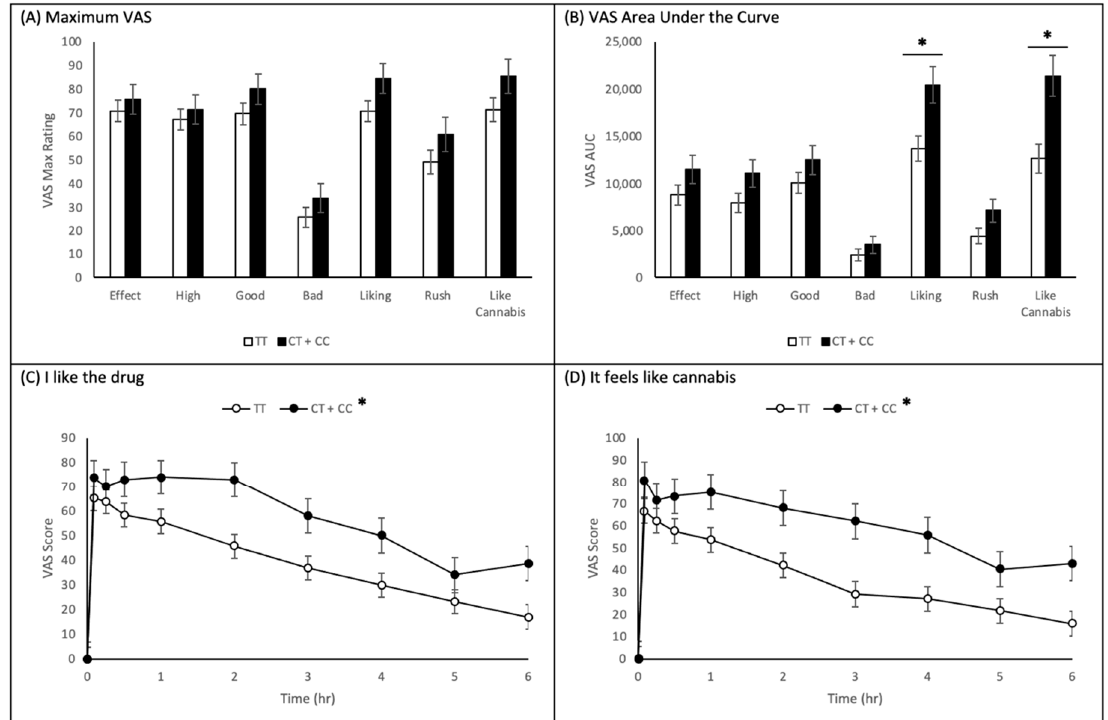
Figure 3. Impact of CNR1 rs2023239 (CT + CC vs. TT.) on Subjective Effects of Cannabis VAS. Measurements (ranging from Not at all to Extremely (0 to 100)) were collected at different time points during acute cannabis intoxication (0–6 h) of n = 52 subjects, separated by rs2023239 genotype. ( A ) Maximum values of VAS scores obtained with various questions. Unadjusted maximum VAS question results: I feel a drug effect ( p = 0.536), I feel this high ( p = 0.591), I feel the drug’s good effects ( p = 0.200), I feel the drug’s bad effects ( p = 0.290), I like the drug ( p = 0.080), I feel a rush ( p = 0.193), and It feels like cannabis ( p = 0.120). ( B ) Area under the curve analysis for VAS values collected. Unadjusted mixed-effects model AUC results: I feel a drug effect ( p = 0.156), I feel this high ( p = 0.082), I feel the drug’s good effects ( p = 0.209), I feel the drug’s bad effects ( p = 0.334), I like the drug ( p = 0.006), I feel a rush ( p = 0.071), and It feels like cannabis ( p = 0.002). ( C , D ) Time course of the scoring for the VAS question ( C ) ‘I like the drug’ and ( D ) ‘It feels like cannabis’. Unadjusted mixed-effects model time course results of I like the drug and ( D ) It feels like cannabis . * p < 0.05, CT + CC vs. TT.